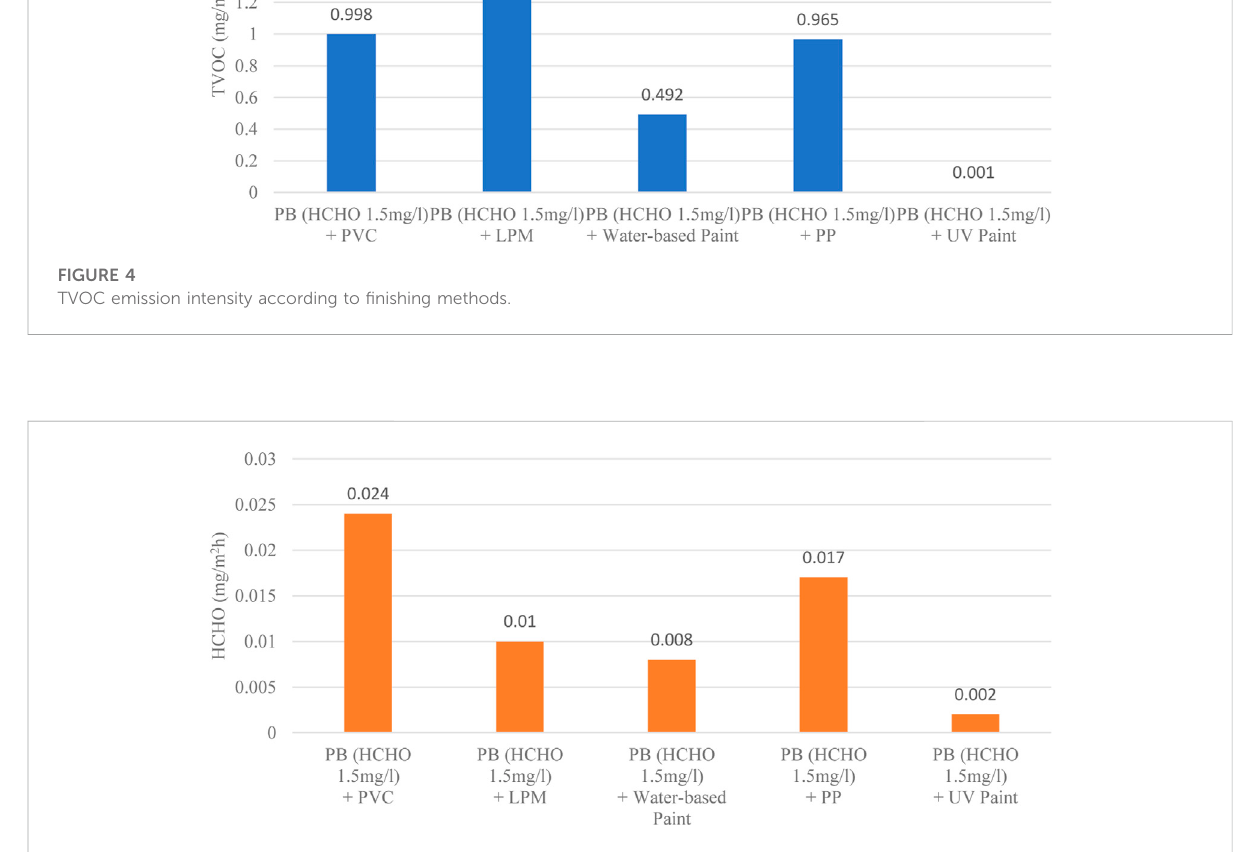
FIGURE 5 HCHO emission intensity according to fi nishing